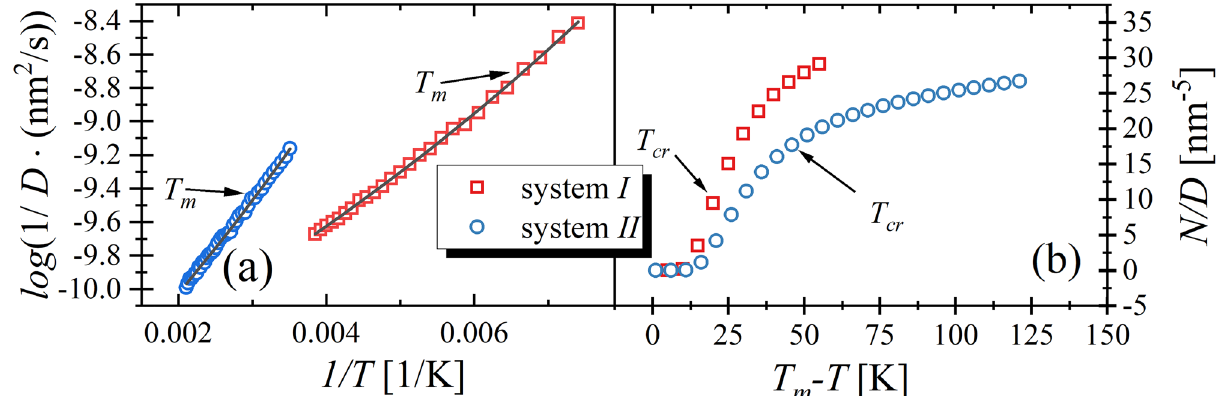
Figure 5. In the left panel the temperature dependences of diffusion constant for RMs systems are presented. The black lines represent the fit of the VFT equation, log 1 = − ( 1068 ± 4 ) 10 − 2 , B = ( 52 ± 3 ) 10 1 K , T 0 = 35 ± 4K for system I and are log D 0 (cid:31) (cid:30) 1 = − ( 1110 ± 7 ) 10 − 2 , B = ( 12 ± 1 ) 10 2 K , T 0 = 17 ± 2K for system II. The right panel shows the values log D 0 (cid:31) (cid:30) of the nucleation rate divided by the diffusion constant for studied